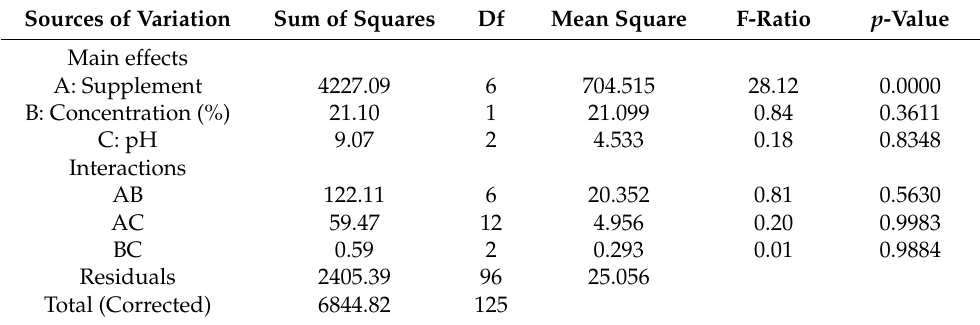
Table 1. Analysis of variance for diameter (mm) obtained in vitro.